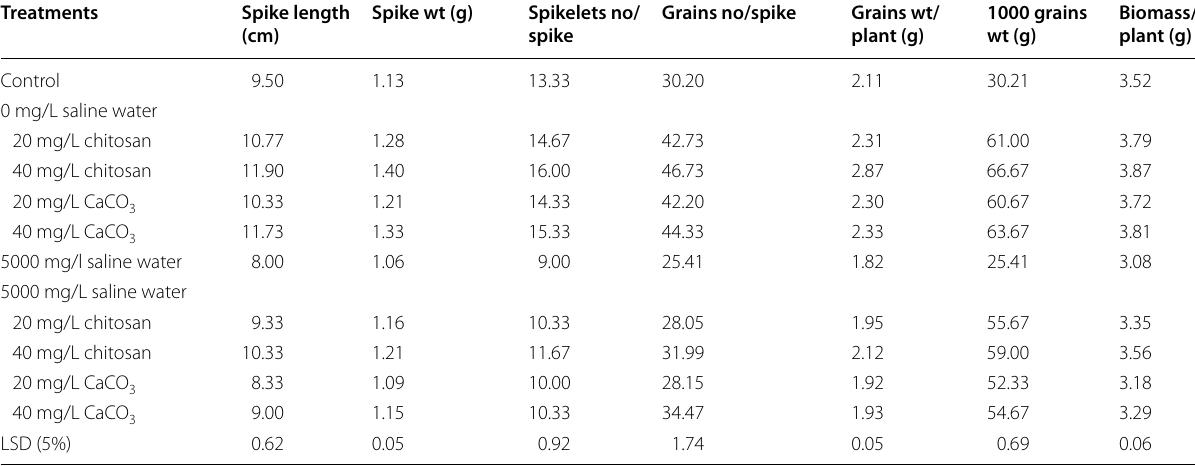
Data are means of two seasons